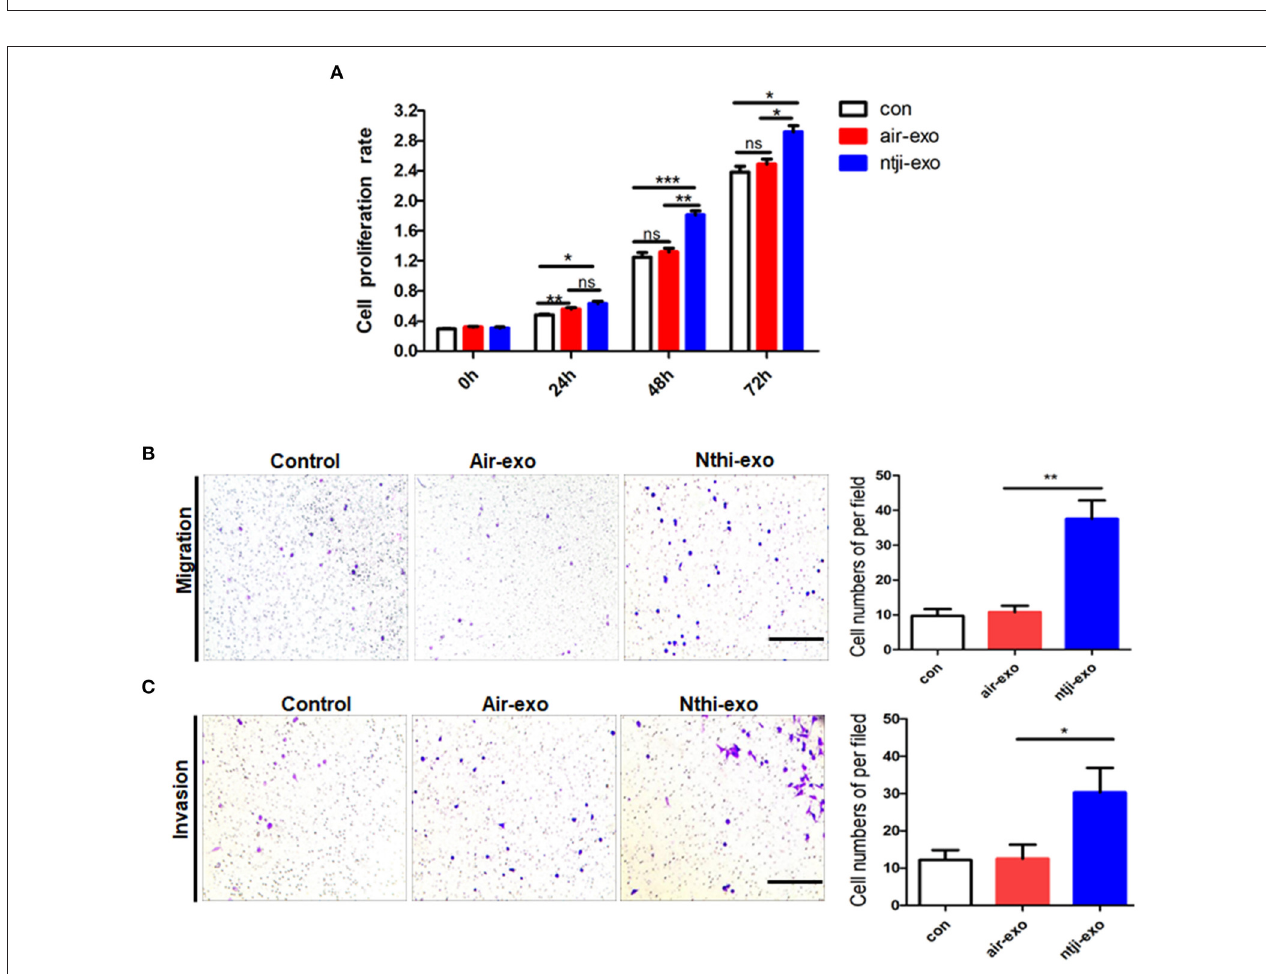
FIGURE 6 | Roles of exosomes from the BALF of mice exposed to NTHi lysate or air. (A) Cell proliferation assay was performed in LLC cells incubated with PBS, air-Exosor NTHi-Exos ( n = 4). (B) Migration assay was performed in LLC cells co-cultured with PBS, air-Exos or NTHi-Exos ( n = 10). (C) Invasion assay was performed in LLC cells co-cultured with PBS, air-Exos or NTHi-Exos ( n = 10). Scar bar = 200 µ m. Results are presented as means ± SEM of three independent experiments. (* P < 0.05, ** P < 0.01, *** P < 0.001).